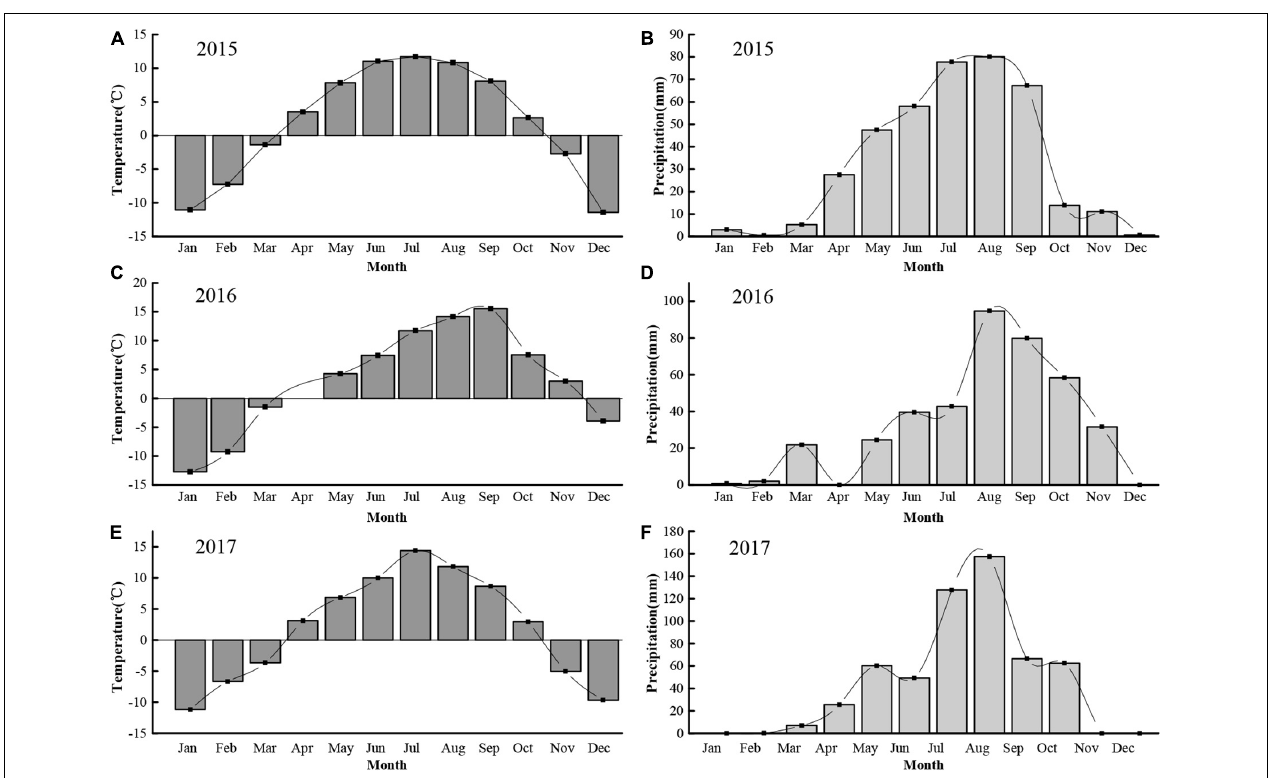
FIGURE 2 | Monthly temperature ( ◦ C) and precipitation (mm) during each of 3 years at the study site. (A,B) Monthly temperature and precipitation in 2015, respectively; (C,D) Monthly temperature and precipitation in 2016, respectively; (E,F) Monthly temperature and precipitation in 2017,